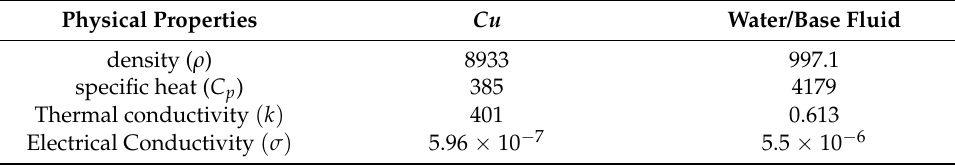
Table 2. Thermophysical properties of nanoparticles Cu and base fluid